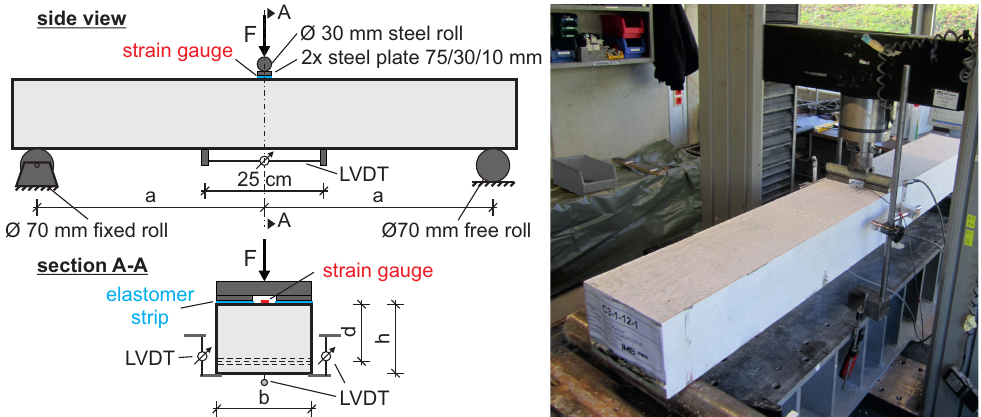
Figure 1. Test setup and instrumentation for three-point bending tests.